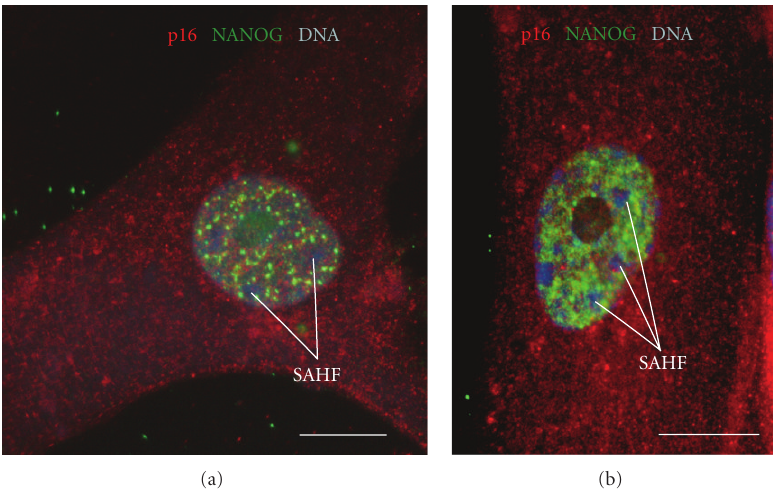
Figure 10: Relatively rare flattening giant fibroblasts displaying at presenescence a considerable accumulation of NANOG filling the whole nucleus in parallel to clear DAPI-positive SAHFs; in addition, the cells contain p16-positive material in the cytoplasm. Images were obtained using BRG three-colour optical filters system. Scale bars = 10 μ m.